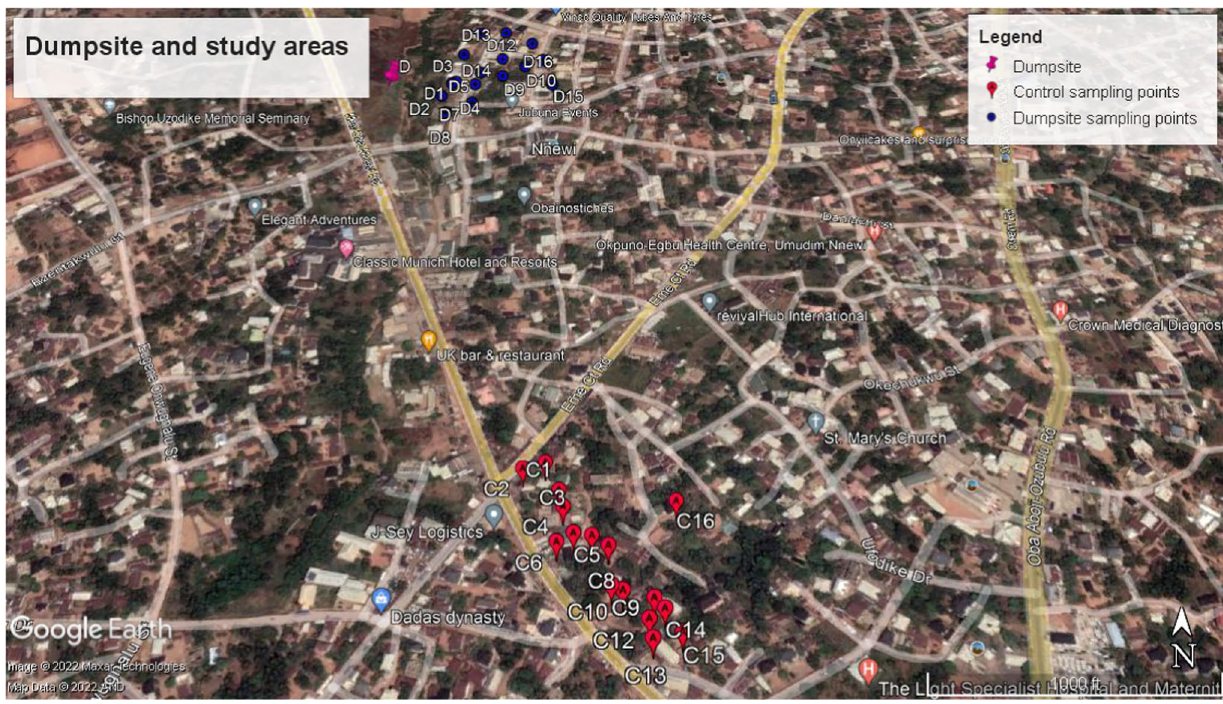
Fig. 1 Map of the dumpsite and sampling